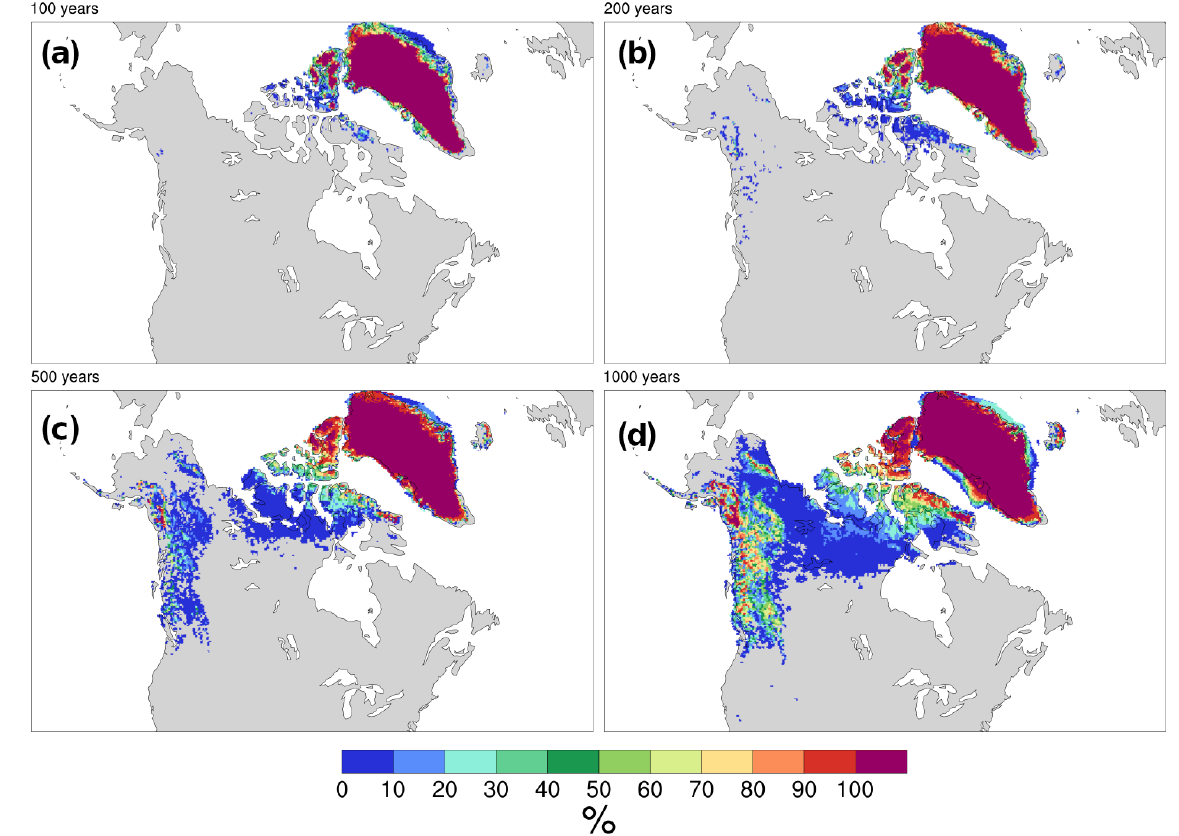
Figure 3. Percent of runs exhibiting ice cover in each grid cell for NA after (a) 100, (b) 200, (c) 500, and (d) 1000 years of simulation.